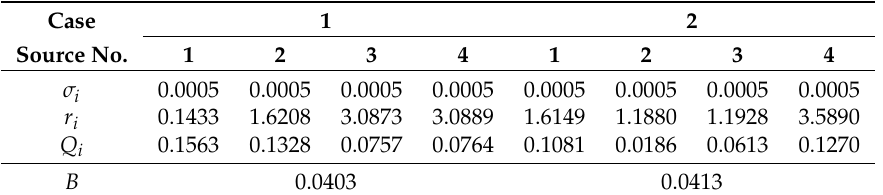
Table 1. Table 1. Parameters of the two EBDFs shown in Figure